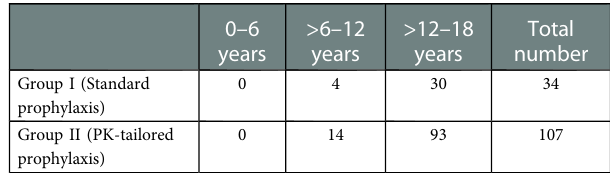
TABLE 1 The age distribution of studied patients.